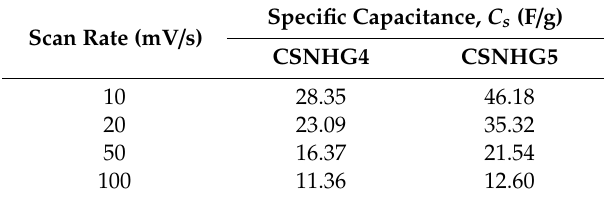
Table 4. Specific capacitance ( C s ) of the fabricated EDLC using different electrolytes at various scan rates.